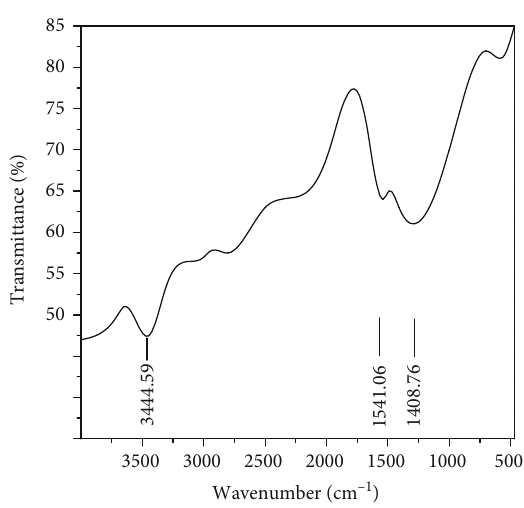
Figure 3: Fourier-transform infrared spectroscopy (FTIR) analysis of